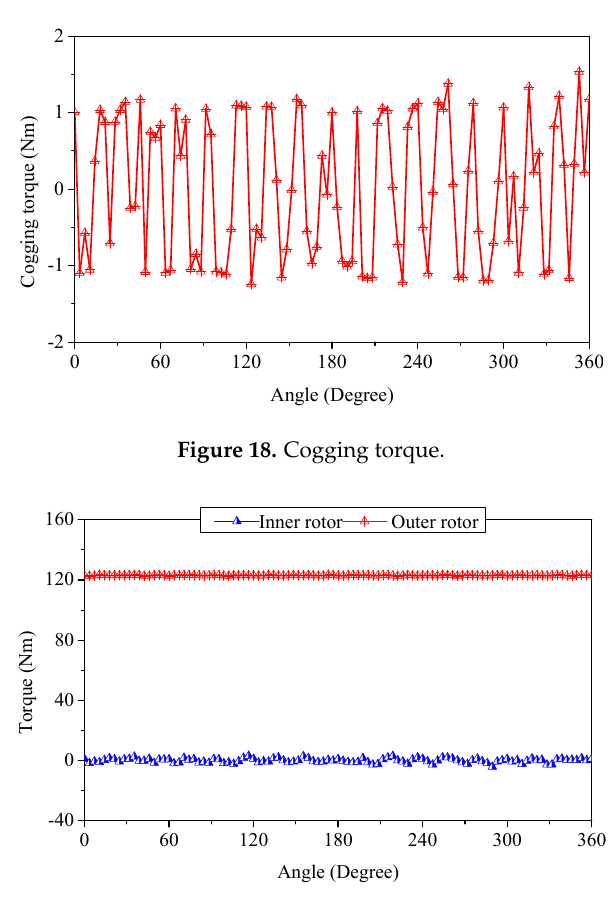
Figure 19. Full load torques.